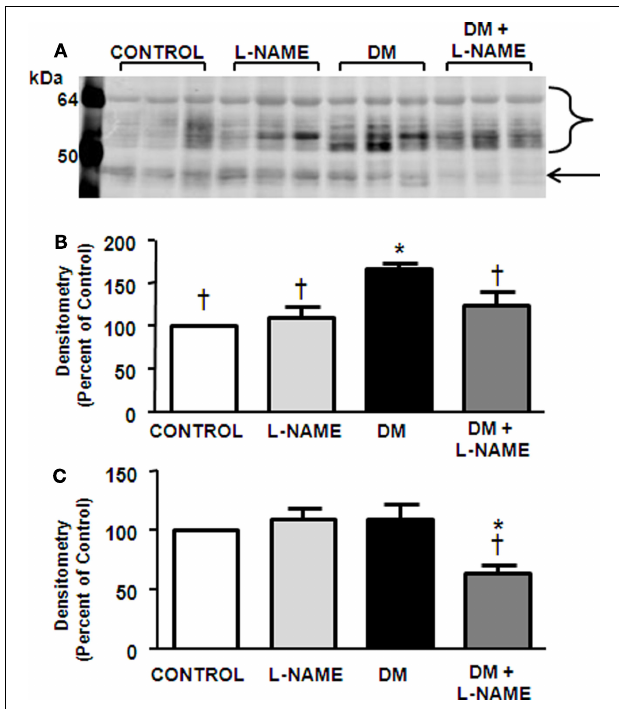
FIGURE 2 | Upregulation of UT-A3 in diabetes is blunted by NO inhibition. Presented is a representative western blot of IM tip (A) probed for UT-A3. Densitometry was determined for all the 65-kDa smear (B) and 45-kDa glyco-form (C) in the IM tip.The experimental conditions were performed five times ( n = 5) where there were five animals per experimental group in each cohort. In total, 25 animals per experimental group were analyzed. * p < 0.05 compared to control, † p < 0.05 compared to